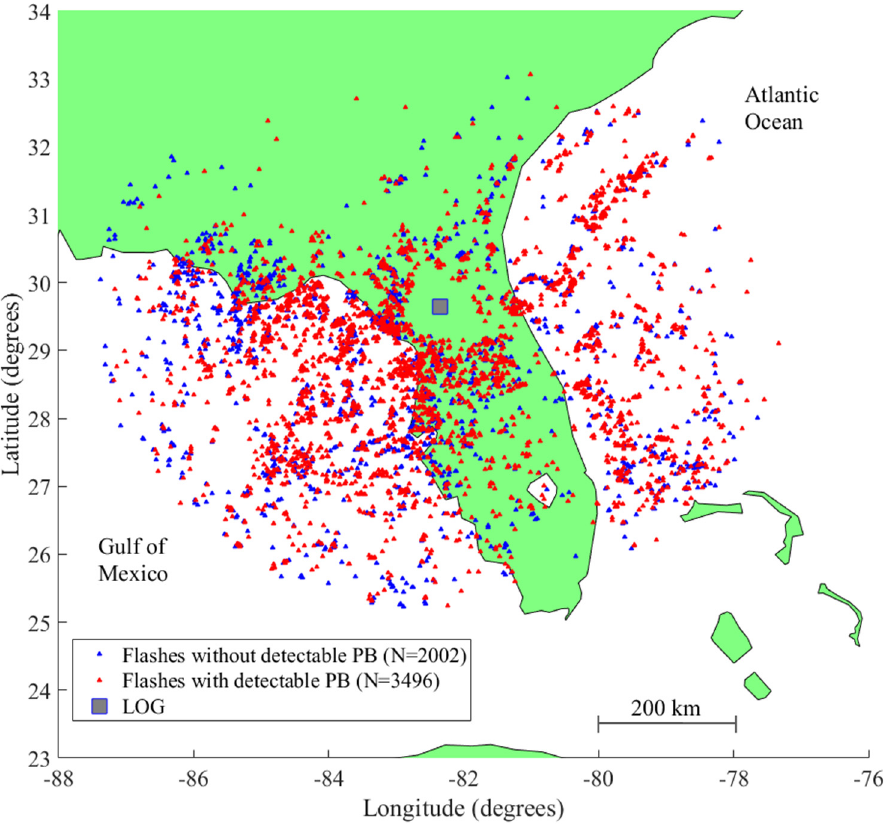
Figure 3. NLDN-reported locations of the 5498 negative first strokes within 50 to 500 km of LOG.